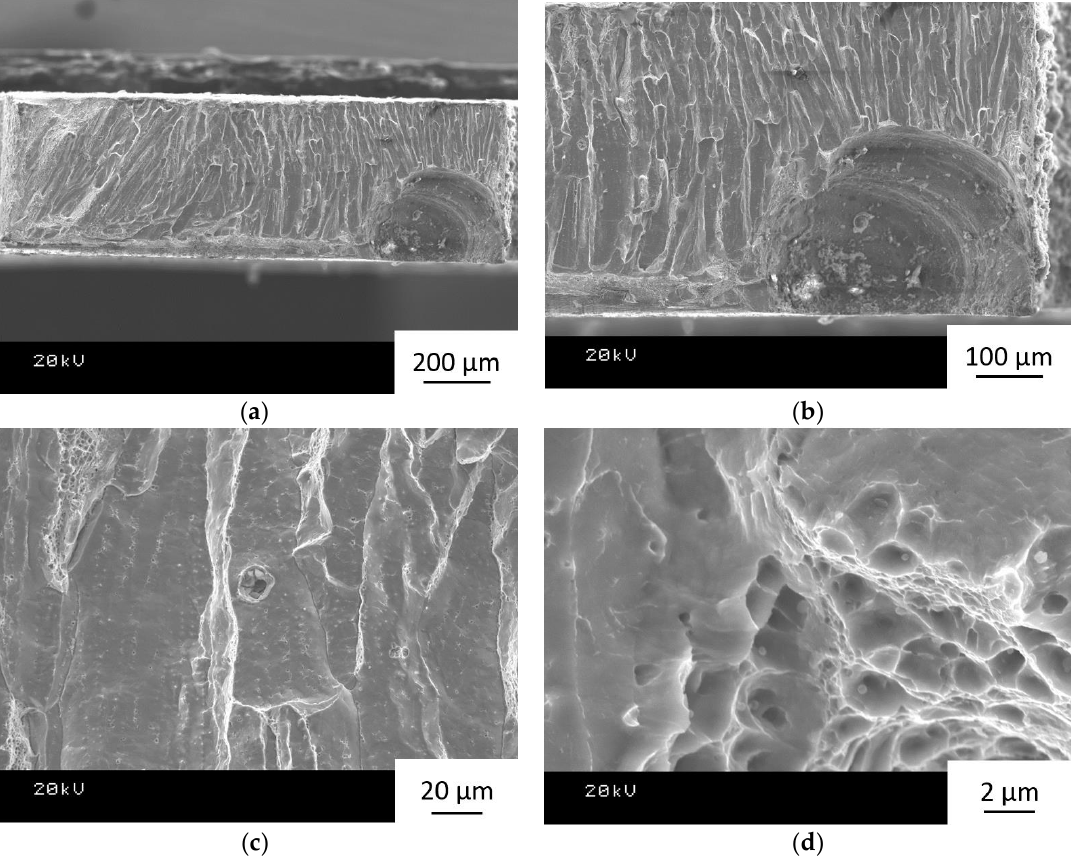
Figure 13. Fracture surface of 19_1 specimen: ( a ) View of the entire fracture surface; ( b ) Detail of the defect—pore in the corner of the fracture surface; ( c ) Predominantly intergranular fracture; and, ( d ) Detail of a ductile fracture region.